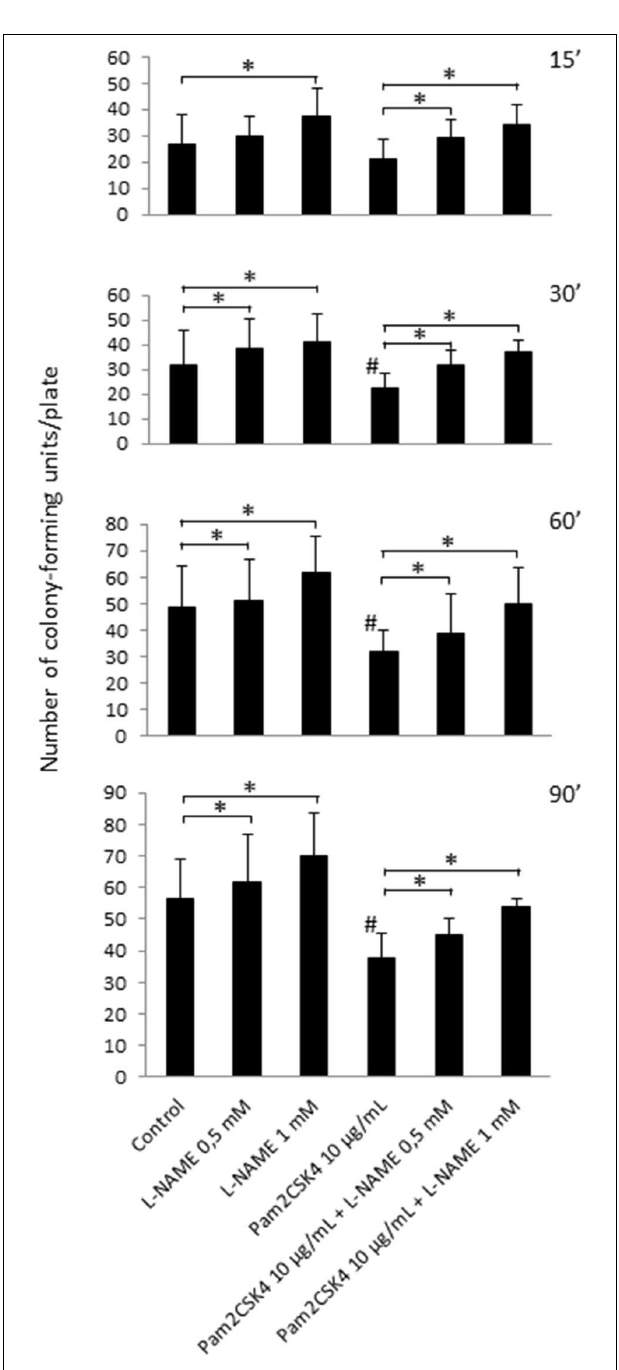
FIGURE 3 | NO released from unstimulated or Pam2CSK4-stimulated odontoblast-like cells alters Streptococcus mutans viability. Analysis of Streptococcus mutans growth after contact of bacteria for 15, 30, 60, or 90min with culture supernatants of cells challenged with 10 µ g/mL Pam2CSK4 for 24h in the presence or in the absence of L-NAME. The number of Streptococcus mutans colony-forming units was reduced when odontoblast-like cells were stimulated with Pam2CSK4 compared to unstimulated ones. Pretreatment with the NOS inhibitor L-NAME increased the number of Streptococcus mutans colony-forming units in both unstimulated and Pam2CSK4-stimulated samples ( n = 6 ). # p < 0 . 05 vs. control unstimulated cells. * p < 0 . 05 vs. cultures without